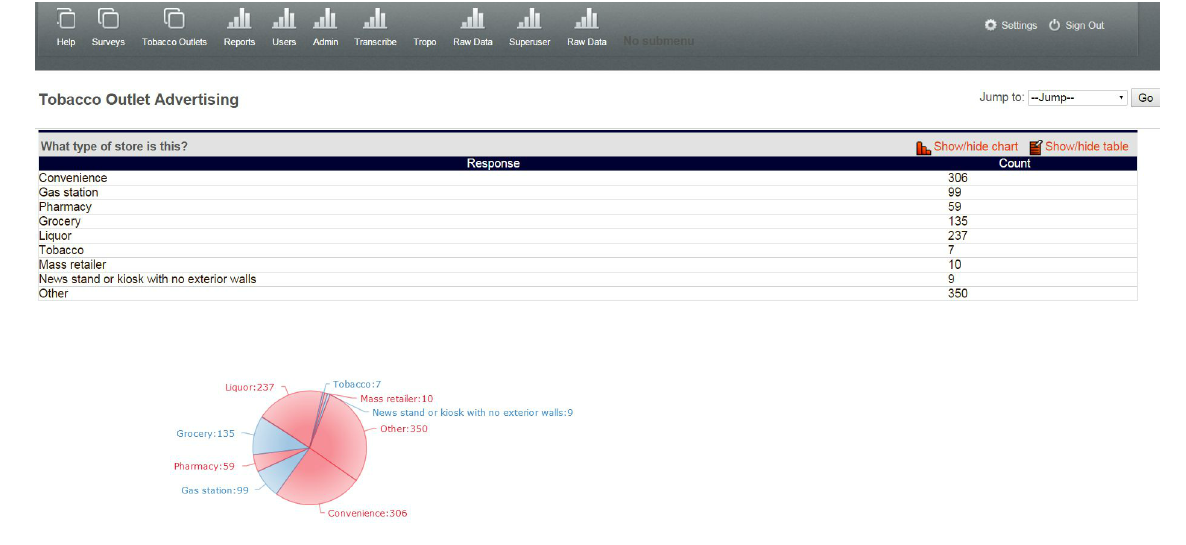
Figure 7. Back-End Database Summary Table and Pie Chart of Aggregated